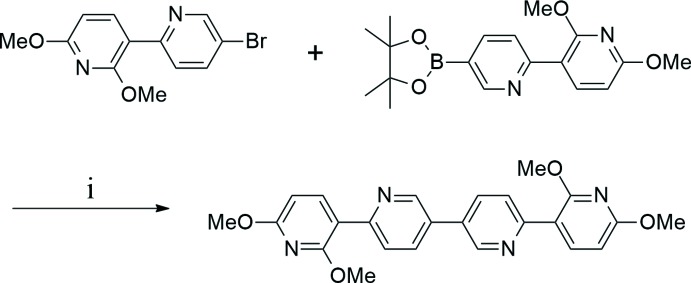
Synthetic routes and reagents to obtain the title compound: (i) Pd(PPh3)4 (5 mol%), K3PO4 (6 eq), THF/H2O, 373 K, 24 h.